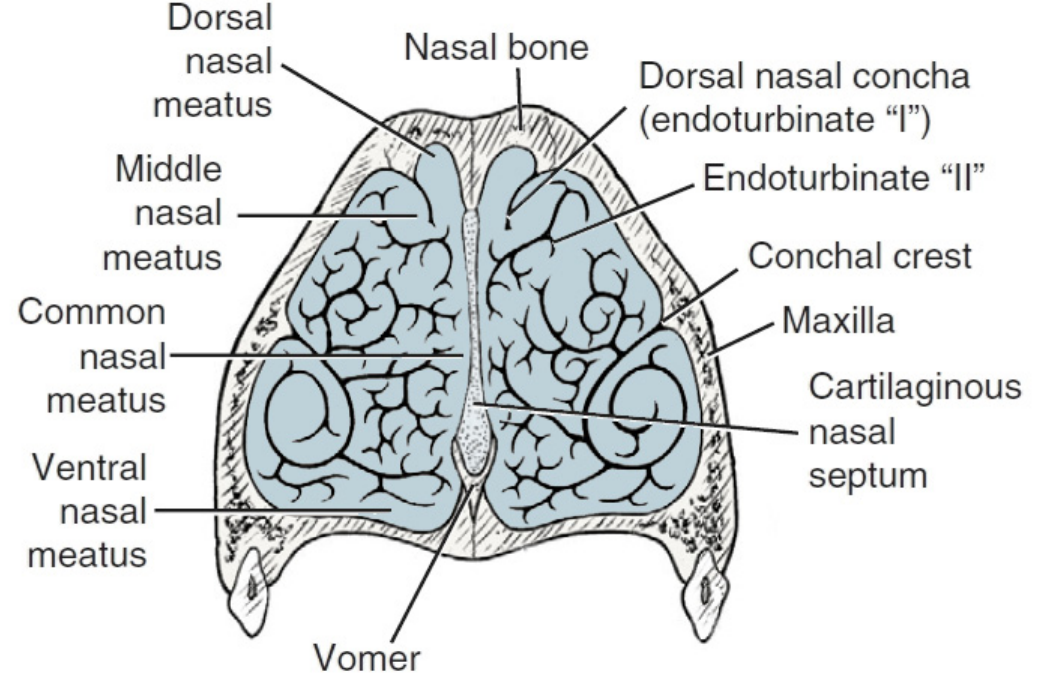
Figure 3. Cross-section of ventral nasal turbinates in dogs. Based on [21]. Anatomically we can distinguish the outer ethmoid turbinate ( ectoturbinalia ), the inner ethmoid turbinate, also known as the dorsal turbinate of the nose ( endoturbinale/concha nasalis dorsalis ), and the first, second, third and fourth inner ethmoid turbinates ( endo- turbinale I, II, III, IV ) (Figure 4). The first ethmoid turbinate is the most dorsal; it is the longest and farthest in the nasal cavity. It forms the skeleton of the dorsal turbinate. The second ethmoid turbinate is located next to the first and is the skeleton of the middle turbinate. Turbinates III and IV are small in most species. The exception is the dog, in which these turbinates are very well formed. The internal ethmoid turbinates are the medial and dorsal nasal turbinates. The outer turbinates are arranged in one row, with the exception of the horse, where they form two rows